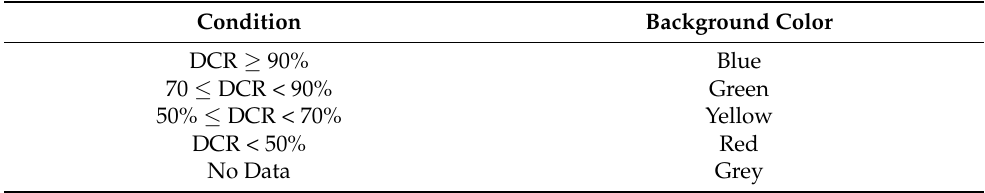
Table 3. Rule for changing DCR background